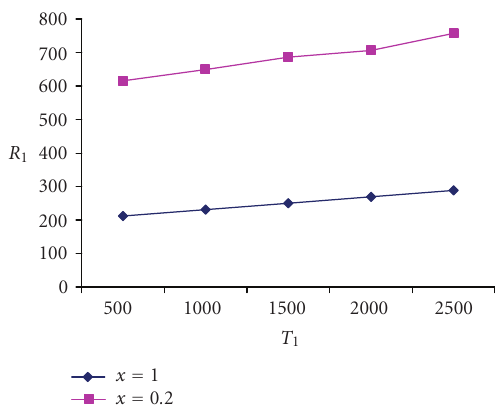
Figure 4.1. The variation of R 1 with T 1 for fixed values of Q 1 = 100 and x = 0 . 2,1.